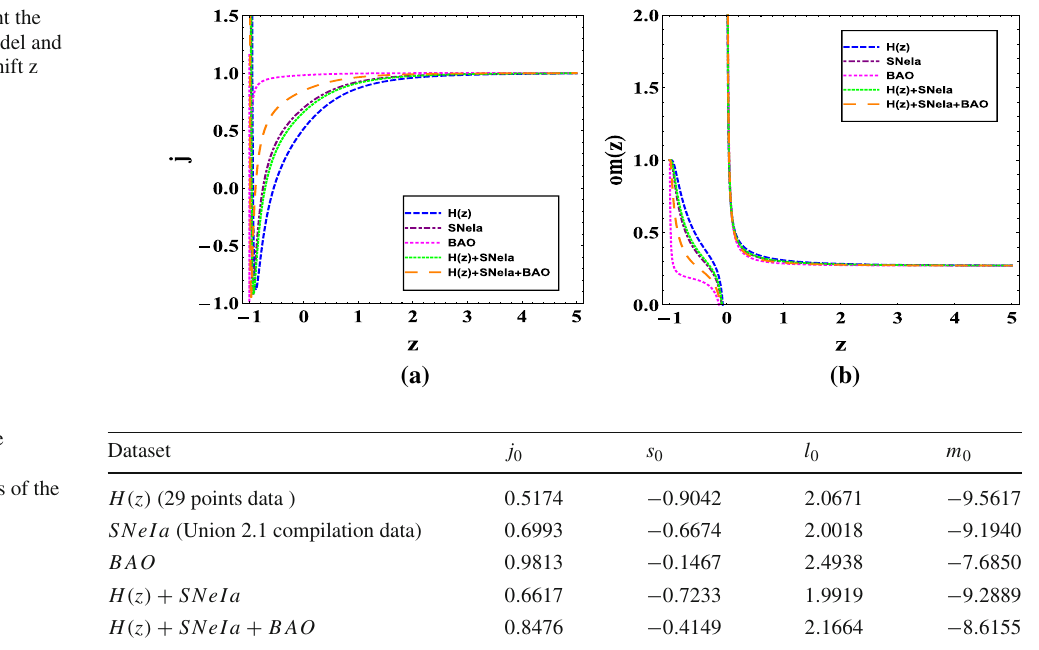
Table 3 Summary of the numerical results of cosmographic parameters of the model